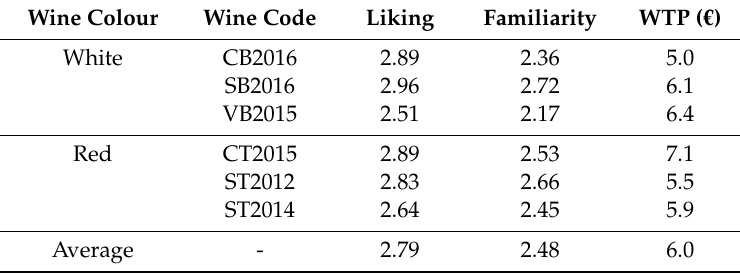
Table 11. Preference and willingness to pay (WTP) of the organic wines by consumers in an informed